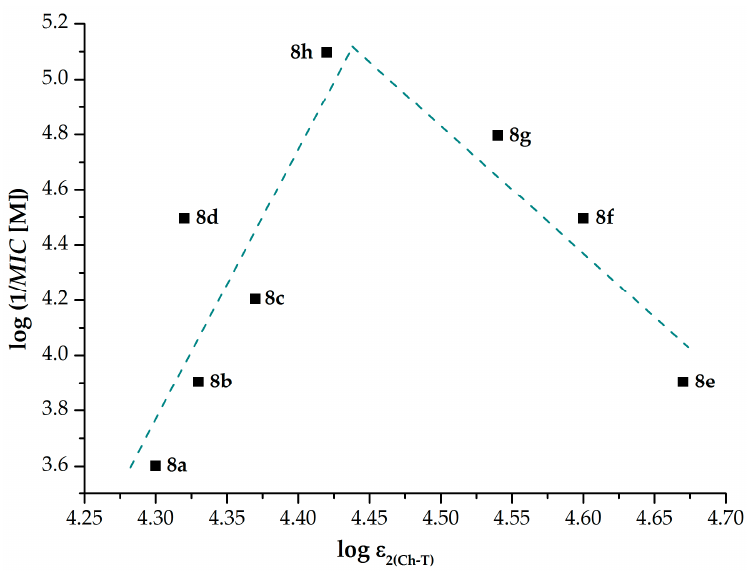
Figure 4. Bilinear relationship between the log ε 2(Ch-T) and log (1/ MIC [M]) parameters of the investigated compounds 8a – h . The dependent variable values were taken from the in vitro screening of these derivatives against M. tuberculosis CNCTC My 331/88 ( M. tuberculosis H 37 R v ;